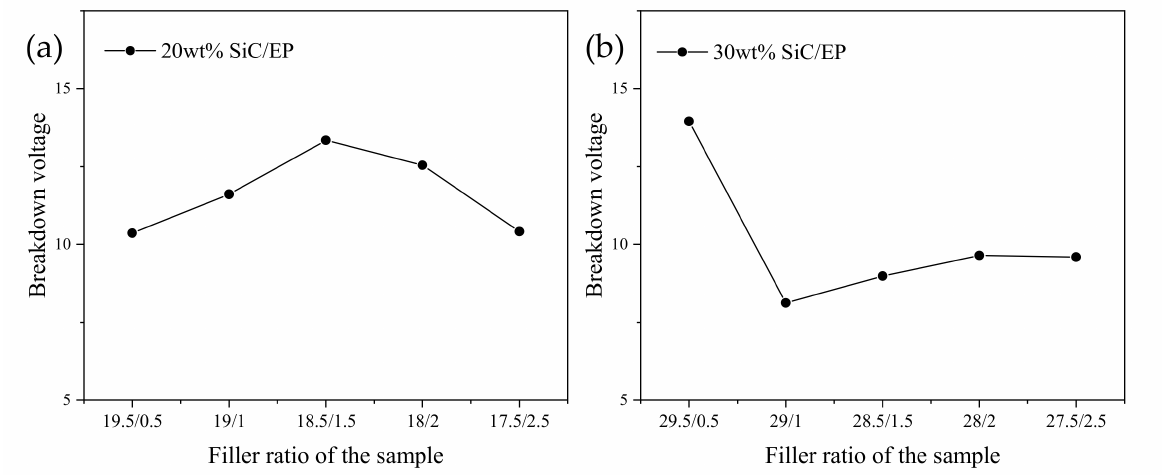
Figure 17. Average breakdown strength of micro-nano composite SiC/EP. ( a ) 20 wt% SiC/EP; ( b ) 30 wt%